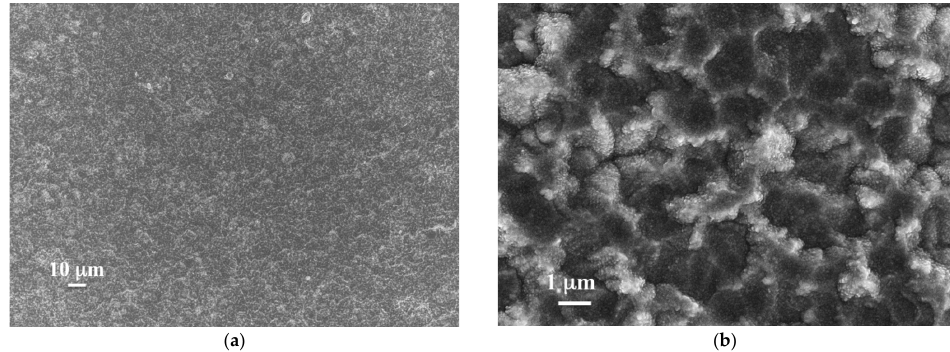
Figure 2. Surface SEM micrographs at different magnifications of the Pd top surface for ZrVTi2 ( a ) and ZrVTiPd3 ( b ) samples. Observing the cross ‐ section of samples, a very compact, dense, and smooth metallic alloy film was detected between the two thin palladium films (see Figure 3, in which some representative cross ‐ sectional views of membranes are reported). Figure 3 shows how the HIPIMS technique was effective in achieving a compact film even on top of the porous and insulating alumina substrate. The backscattered electron images also highlight the two thin palladium films on top and at the metal/alumina interface.